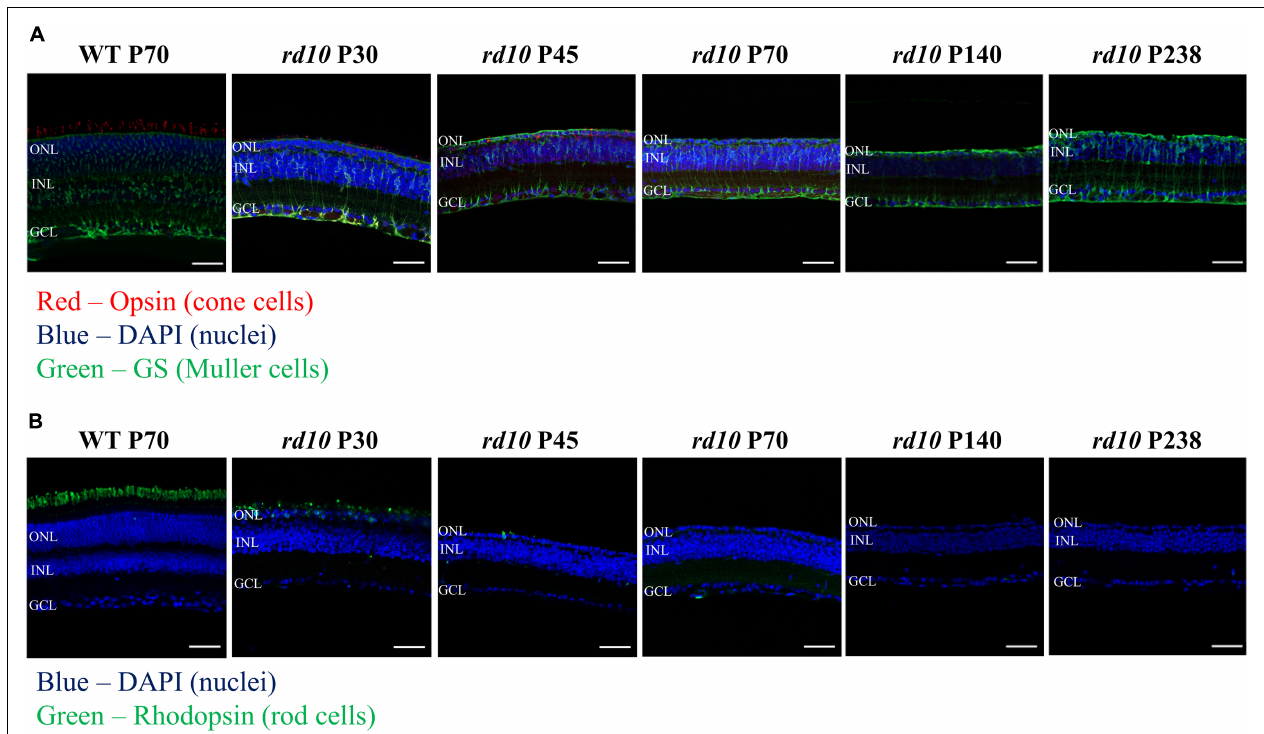
FIGURE 4 | The progressive photoreceptor death by postnatal days in rd10 mouse. (A) Opsin (red) and glutamate synthase (green) double labeling in the wild-type (WT) mice (C57BL/6J strain) at P70 and rd10 mice (C57BL/6- Pde6b em 1 ( R 560 C ) Dkl /Korl strain) at P30, P45, P70, P140, and P238. (B) Immunostaining for rhodopsin (green) in WT mice and rd10 mice. Nuclei are stained with DAPI (blue). Scale bars = 50 µ m. ONL, outer nuclear layer; INL, inner nuclear layer; GCL, ganglion cell layer.